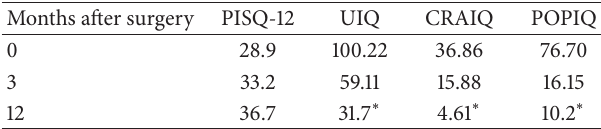
Table 4: Quality-of-life